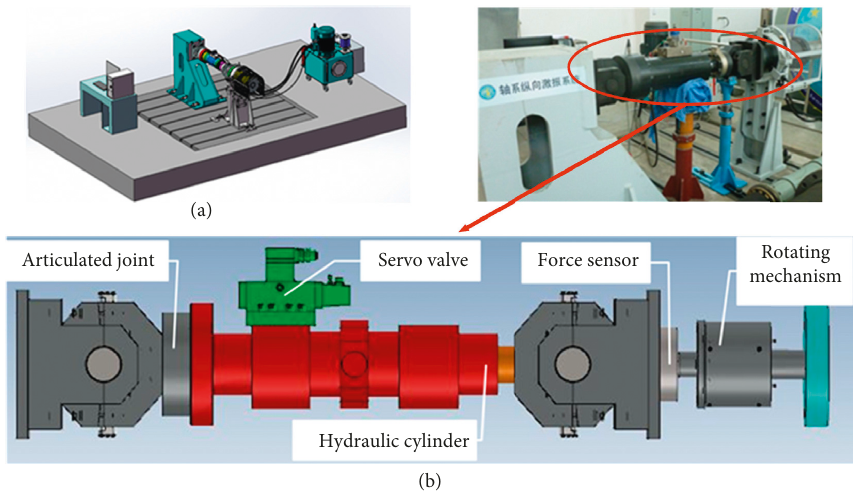
Figure 7: Axial excitation system. (a) Structural sketch. (b) Detail structure.